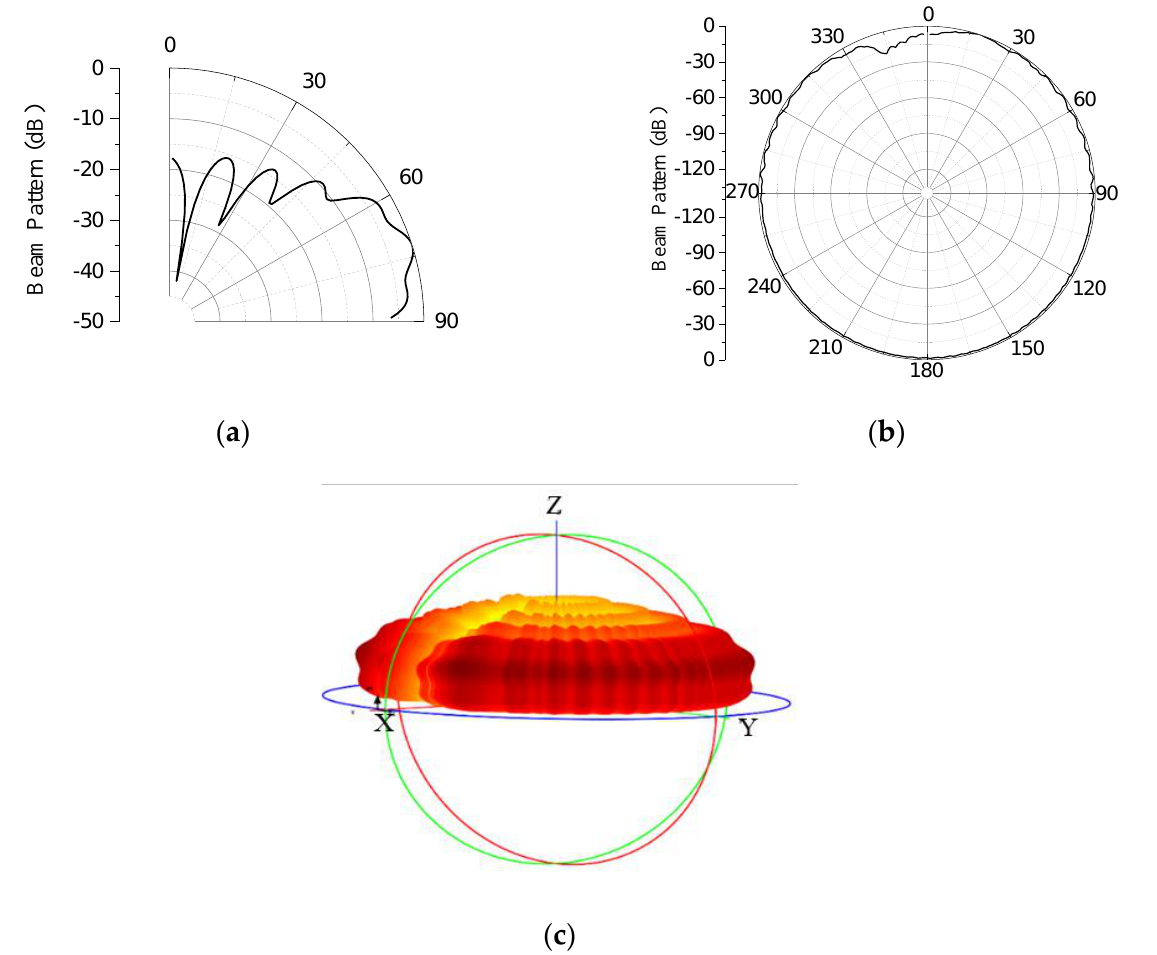
Figure 7. Beam patterns of the GFA on: ( a ) elevation plane; ( b ) azimuth plane; and ( c ) three−di- Beam patterns of the GFA on: ( a ) elevation plane; ( b ) azimuth plane; and mensional space. ( c ) three − dimensional